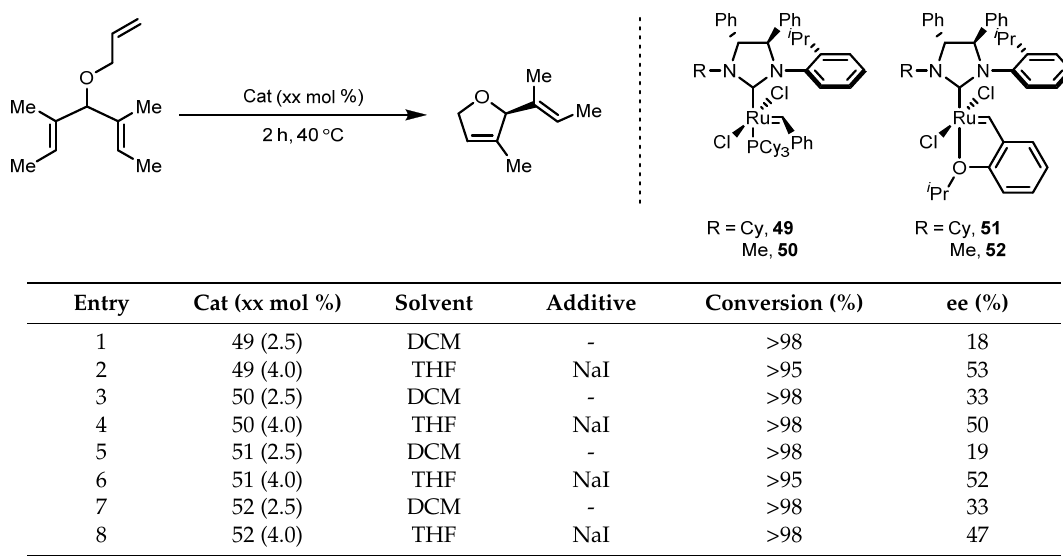
Table 14. Effects of the N -alkyl groups on the enantioselectivity of ARCM using unsymmetric NHC ligands are negligible.